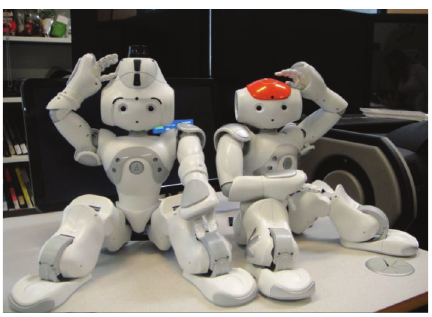
Figure 1: Aldebaran-robotics NAO